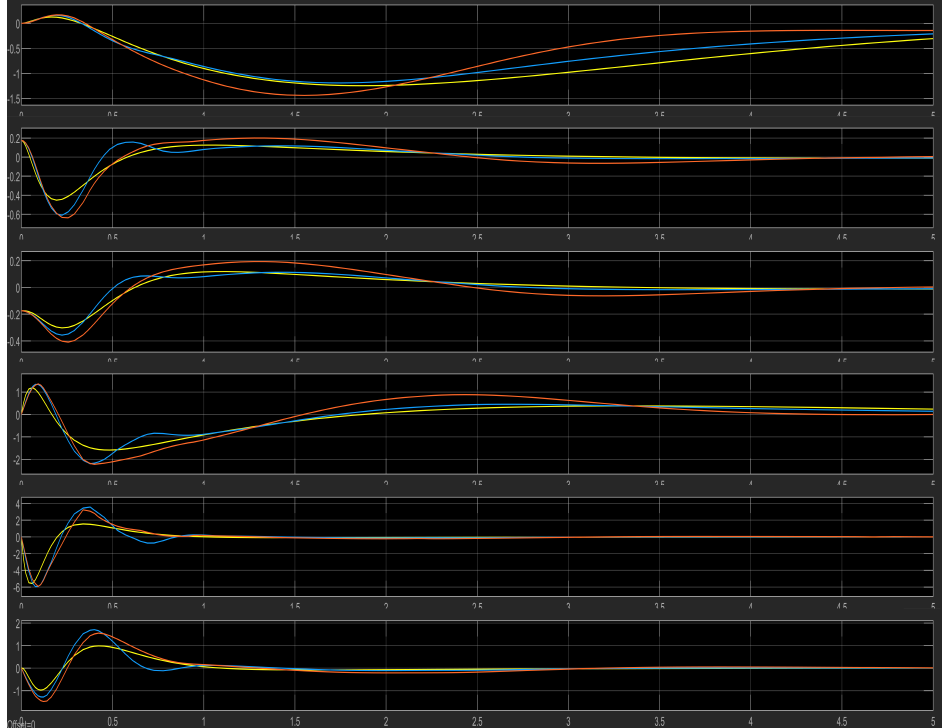
Figure 26. LQR (yellow), FLC (light blue) and new FLC (orange).